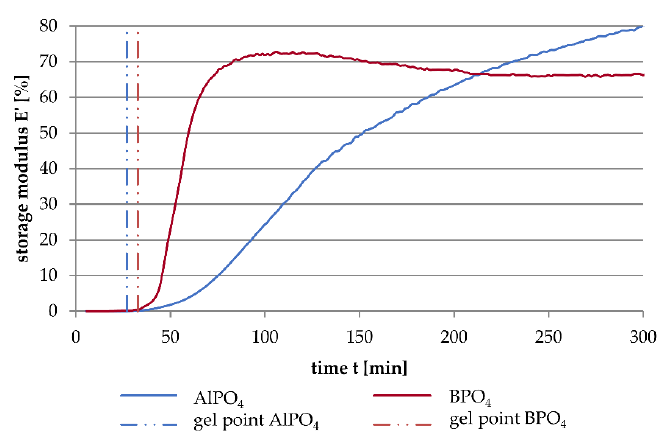
Figure 6. Differences in the development of the storage modulus of the waterglass samples with added content of AlPO 4 and BPO 4 , (20 mass% hardener, T A = 35 °C). The gel points of the samples are indicated by the dashed lines.